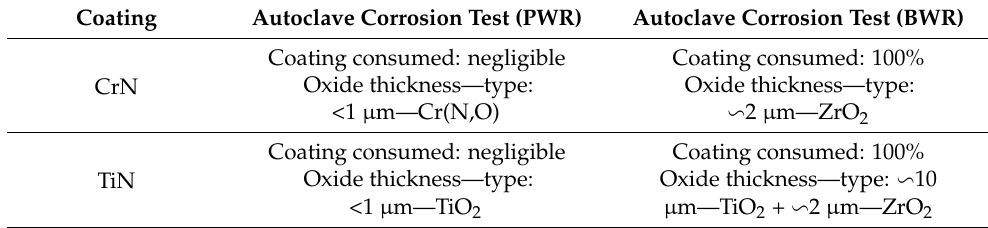
Table 2. Summary of the results of the current study.